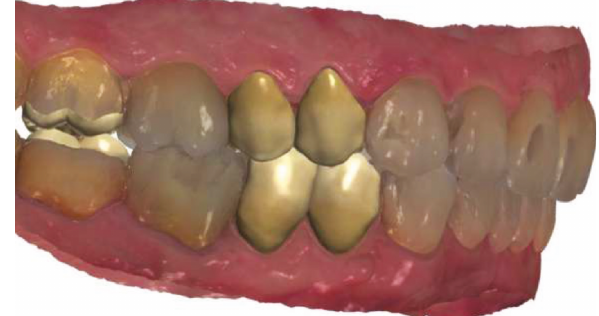
Figure 9: Maxillary and mandibular computer-aided design of lithium disilicate